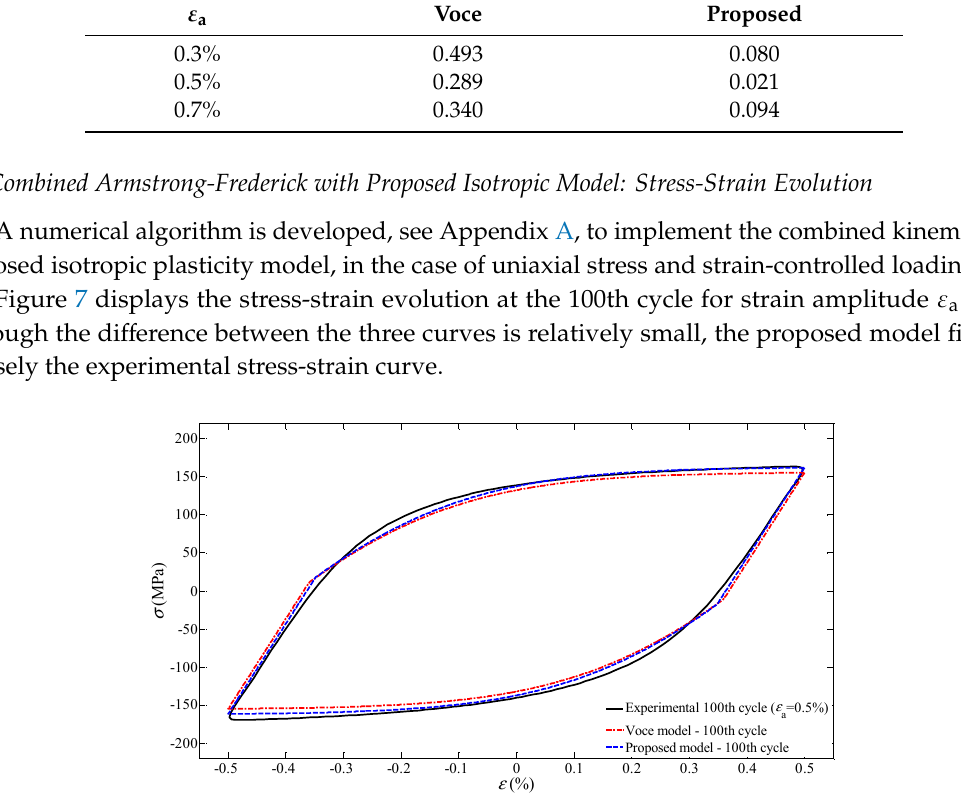
Figure 7. Stress-strain evolution of 100th cycle for strain amplitude ε a = 0.5%, comparison between experiments, combined model with Voce and with proposed isotropic models.